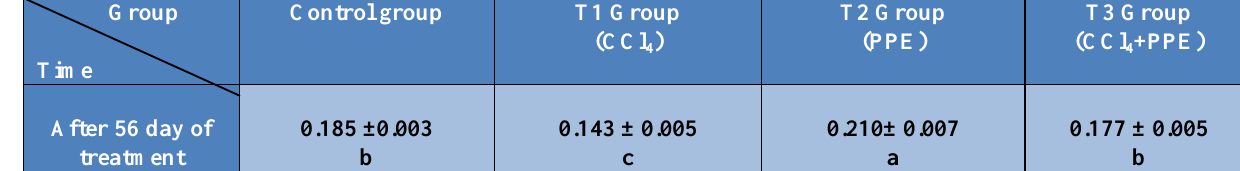
Table , 2: Effect of CCl in adult male rabbit